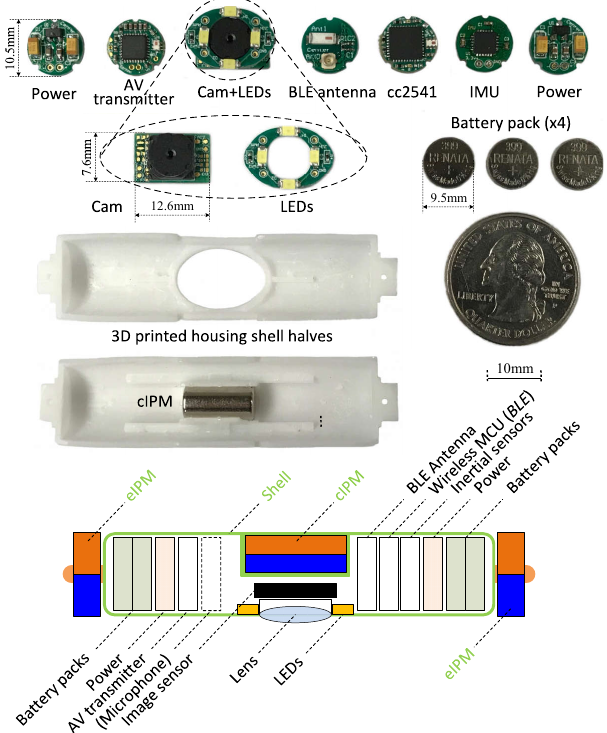
Figure 7. Implementation and layout of camera onboard